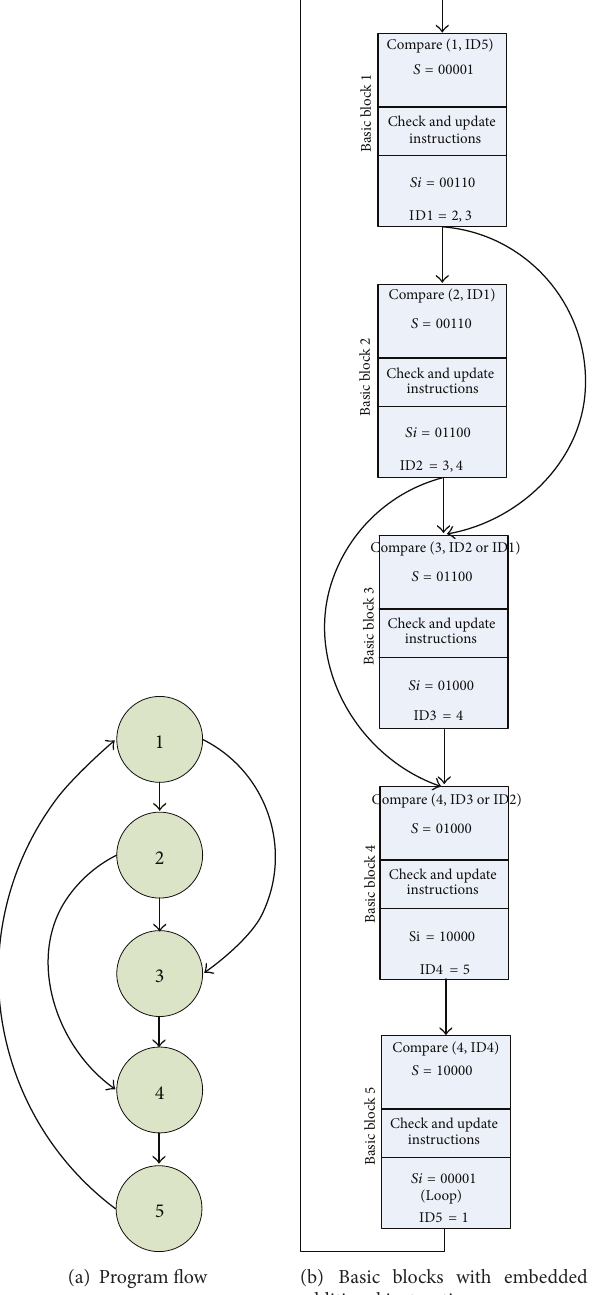
Figure 3: An example of the SCFC operations for control flow error